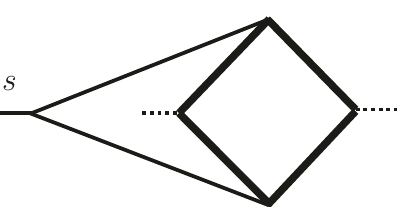
Figure 9 . Elliptic sub-topology for topology F. The thick lines represent massive propagators (top quarks), while the thin lines represent massless propagators (gluons). The dashed external legs are light-like, while the solid external leg is